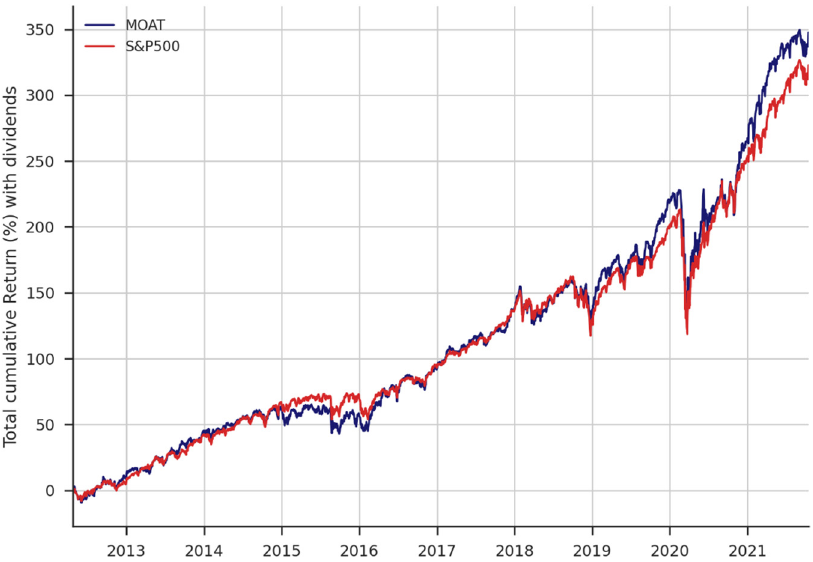
Figure 1. MOAT vs. S&P 500